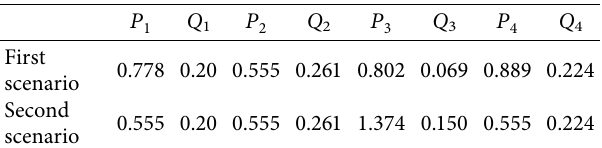
Table 3: Te per-unit power of generators under diferent scenarios.